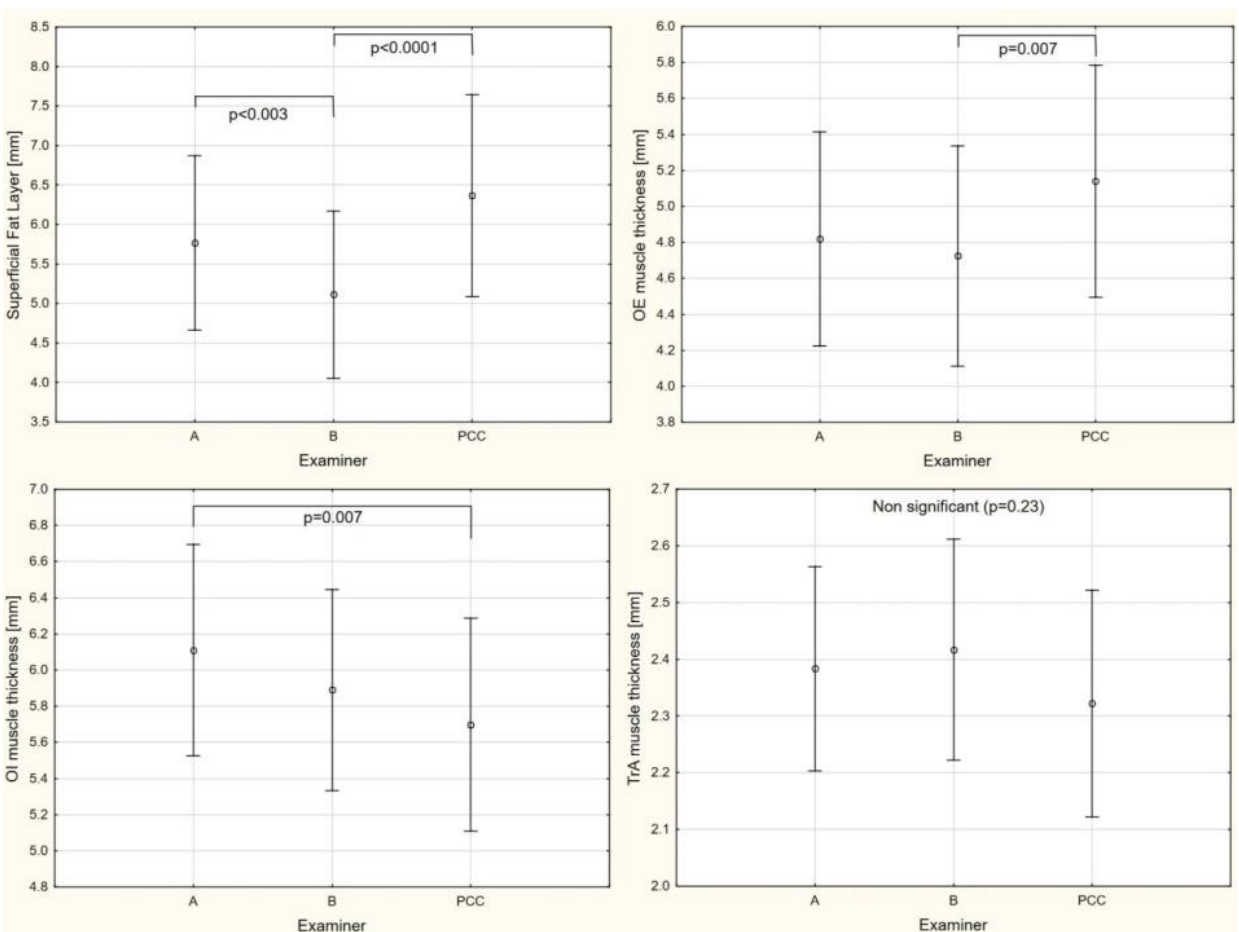
Figure 4. Absolute muscle and superficial fat thickness performed by examiner A, B, and with probe compression controlled (PCC). OE: Oblique external; OI: Oblique internal; TrA: Transversus abdominis.